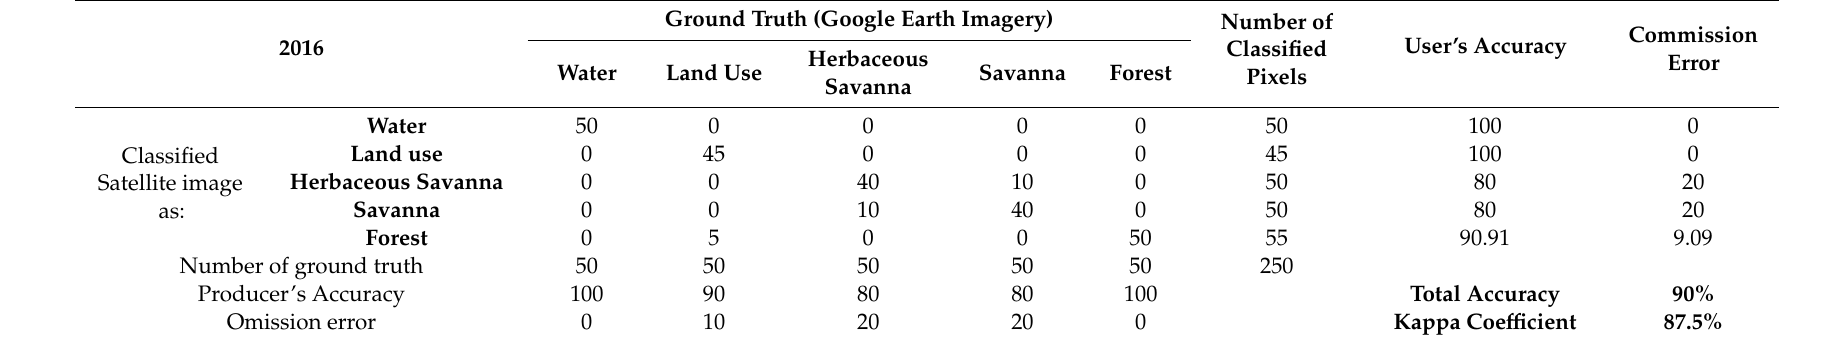
Table A3. Confusion matrix of the land use / cover classification for 2016